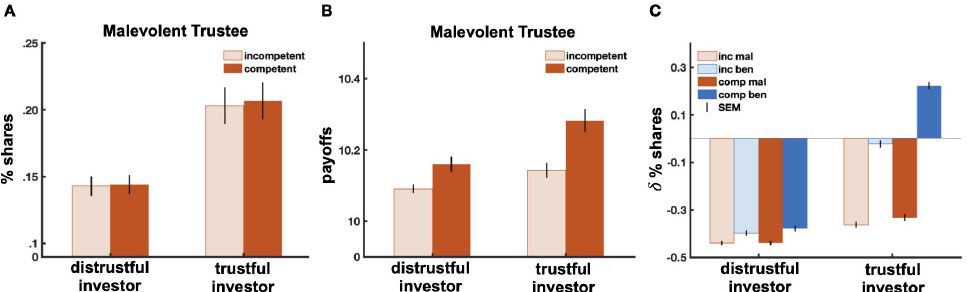
Figure 8. Investment and payoff comparison across trustee types. Comparison of percentage of investments ( A ) and obtained payoffs ( B ) of distrustful (left) and trustful (right) investors for inter- actions with malevolent trustees who were additionally incompetent (light red) or competent (red). Differences of percentage shares ( C ) between the default initial strategy of i t = 0.5 at t = 1,2 and the first expectation-based investment i t at t = 3 across all trustee types for distrustful (left) and trustful (right) investors. Inc: incompetent; Comp: competent; Mal: malevolent; Ben: